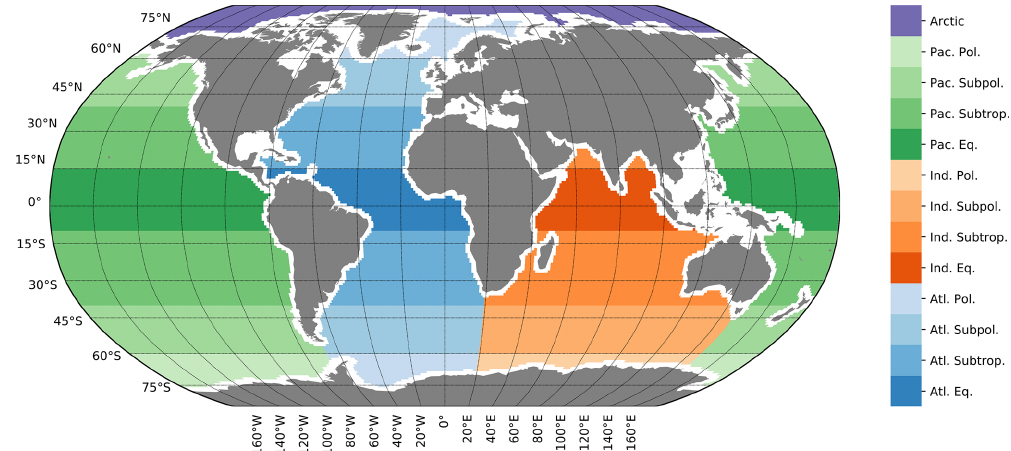
Figure A1. Map of the different ocean basins considered in the analysis: the open ocean is the coloured area at least 250km from the coast (small islands excluded). Note that an asymmetry was considered in the tropics for the regional basins between the Southern Hemisphere and Northern Hemisphere due to the difference in the locations of the subtropical